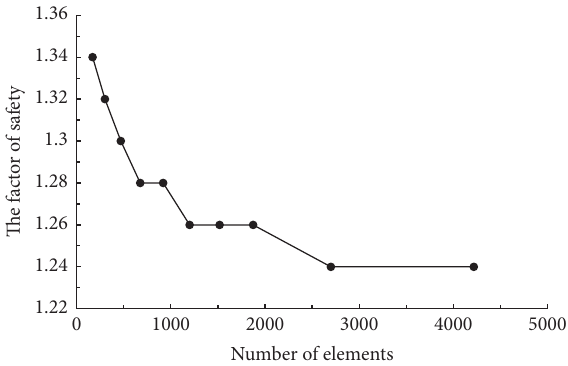
Figure 6: Factor of safety obtained by SRM with different element numbers.